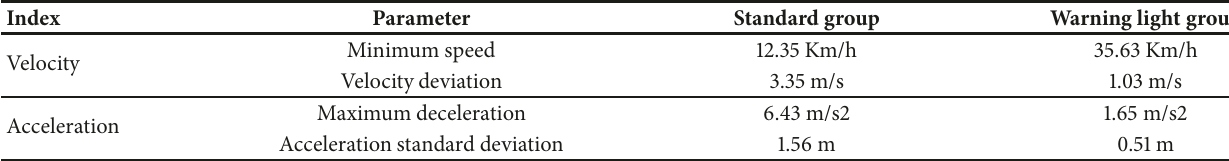
Table 4: Vehicle operation status under different warning scenarios.